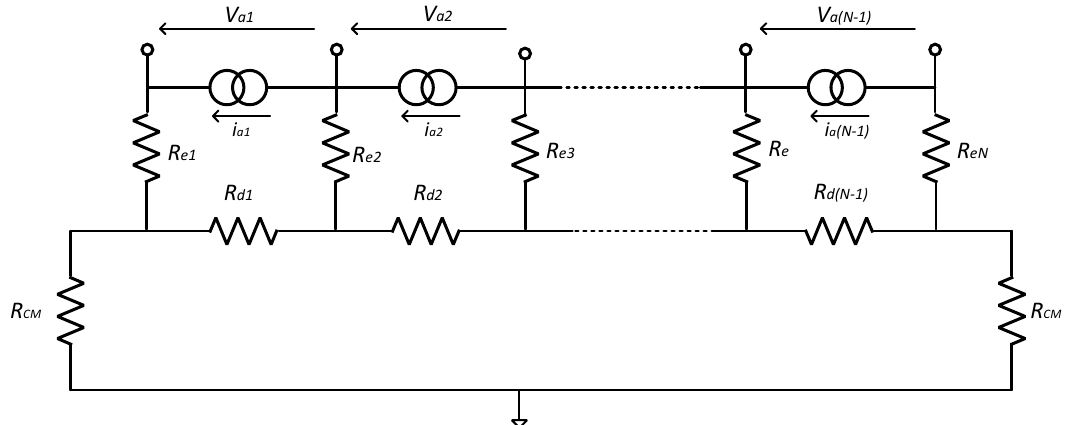
Figure 6. Simplified passband equivalent circuit for amplifier current noise analysis applicable to both Type 1 and Type 2 circuits.